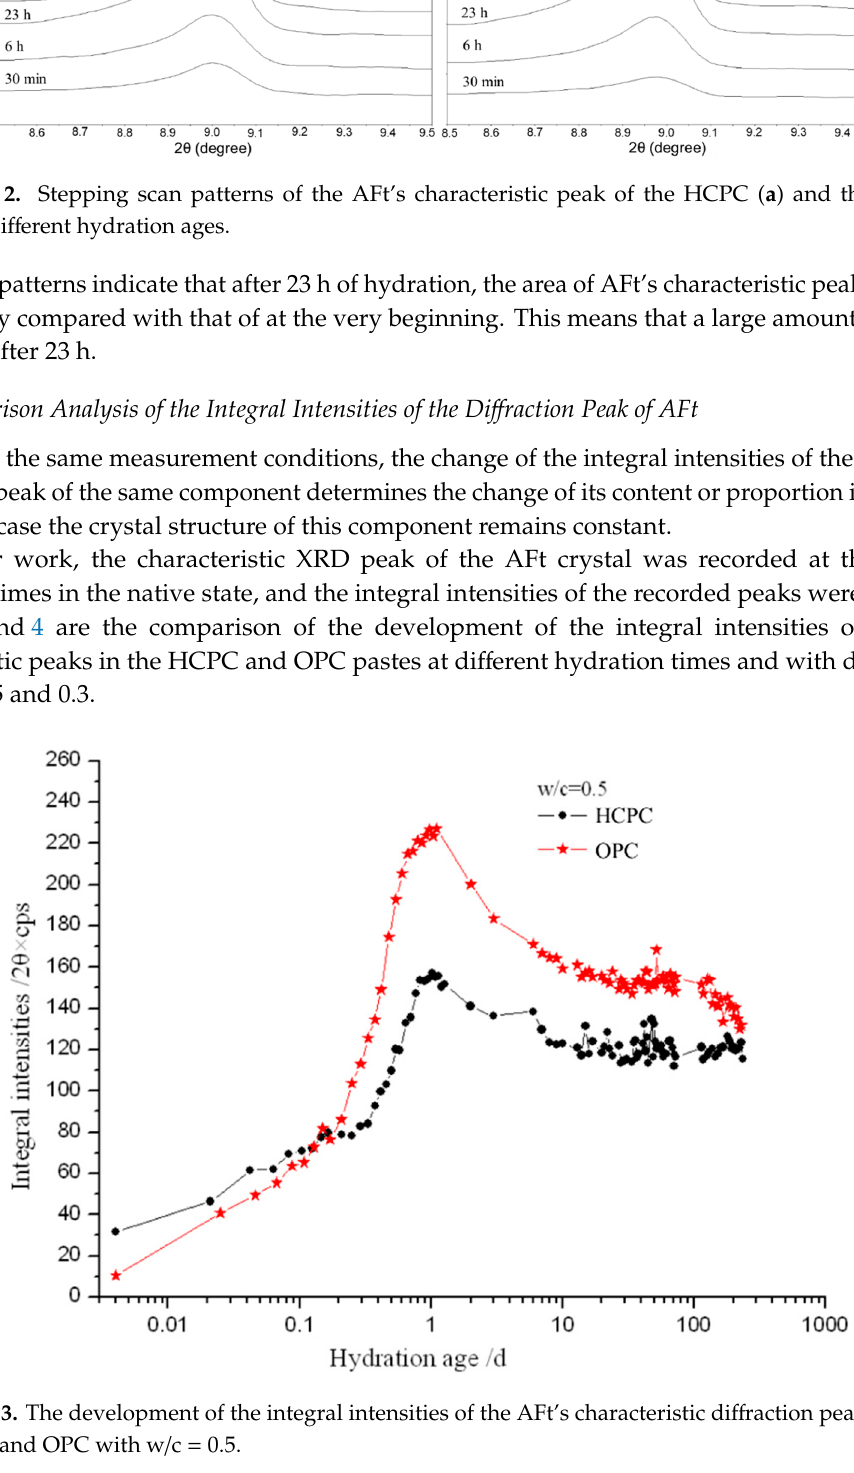
Figure 1. XRD patterns of the hydrated HCPC and OPC after 23 h.